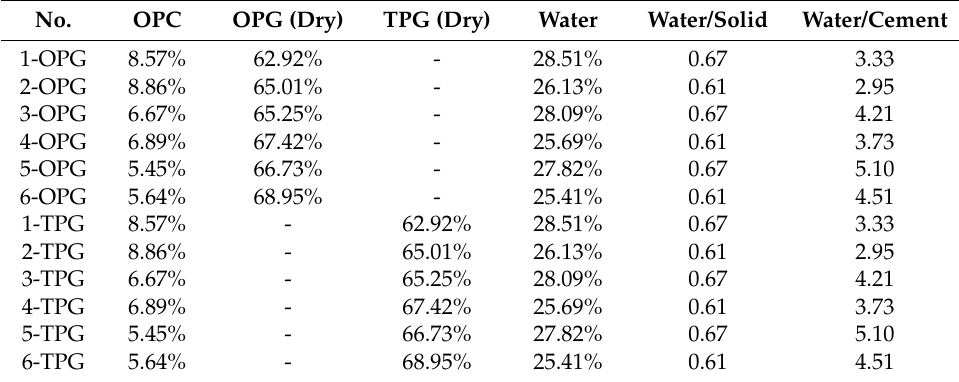
Table 4. Mix proportions of PG-based cemented paste backfill